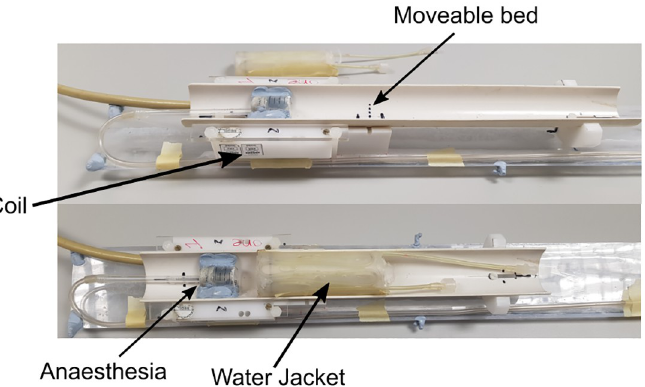
Fig 1. Scanning setup. A custom-made cradle was designed for full body mouse imaging using a rat head surface coil. A water jacket is placed on top of the mouse to maintain body temperature in the scanner. Anaesthetic is fed through a tube to the mouse during the scan session. A moveable half cylindrical bed is placed on top of the 4-channel rat head surface coil to allow optimal positioning of the mouse in the scanner. This also protects the